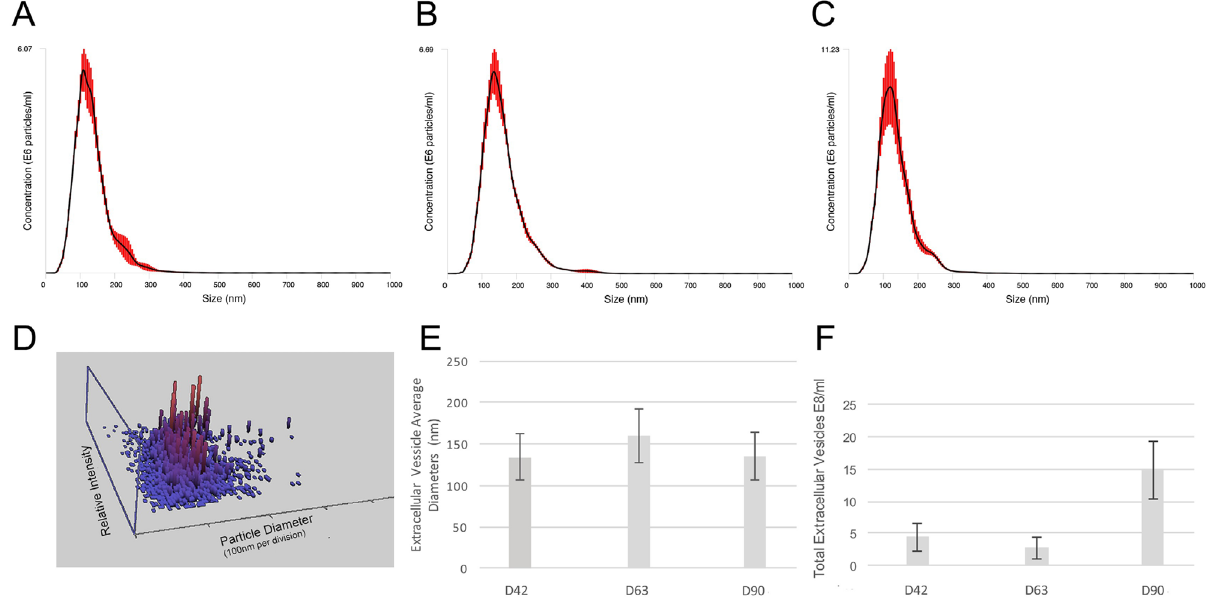
Figure 2. hiPSC-derived 3D retinal organoid-released EV diameter and concentration. ( A–C ) Diameter vs concentration distribution of EVs derived from 3D retinal organoid conditioned media at D42 ( A ), D63 ( B ), and D90 ( C ). ( D ) A 3D distribution plot showing size and relative density of EVs released into media from 3D retinal organoids at D90. The highest concentrations of EVs (red) cluster around 100 nm diameter region. ( E ) Average diameter of EVs released from 3D retinal organoids in culture at the corresponding developmental stages analyzed. Error bars: standard error of the mean. ( F ) Concentration of released EVs from 3D retinal organoids (n = 10) each at D42 = 4.4 ± 2.21 E8/ml; D63 = 2.7 ± 1.60E8/ml; and D90 = 14.8 ± 4.43E8/ ml. Concentration data were normalized to control media for each time point. A sample of Brownian motion